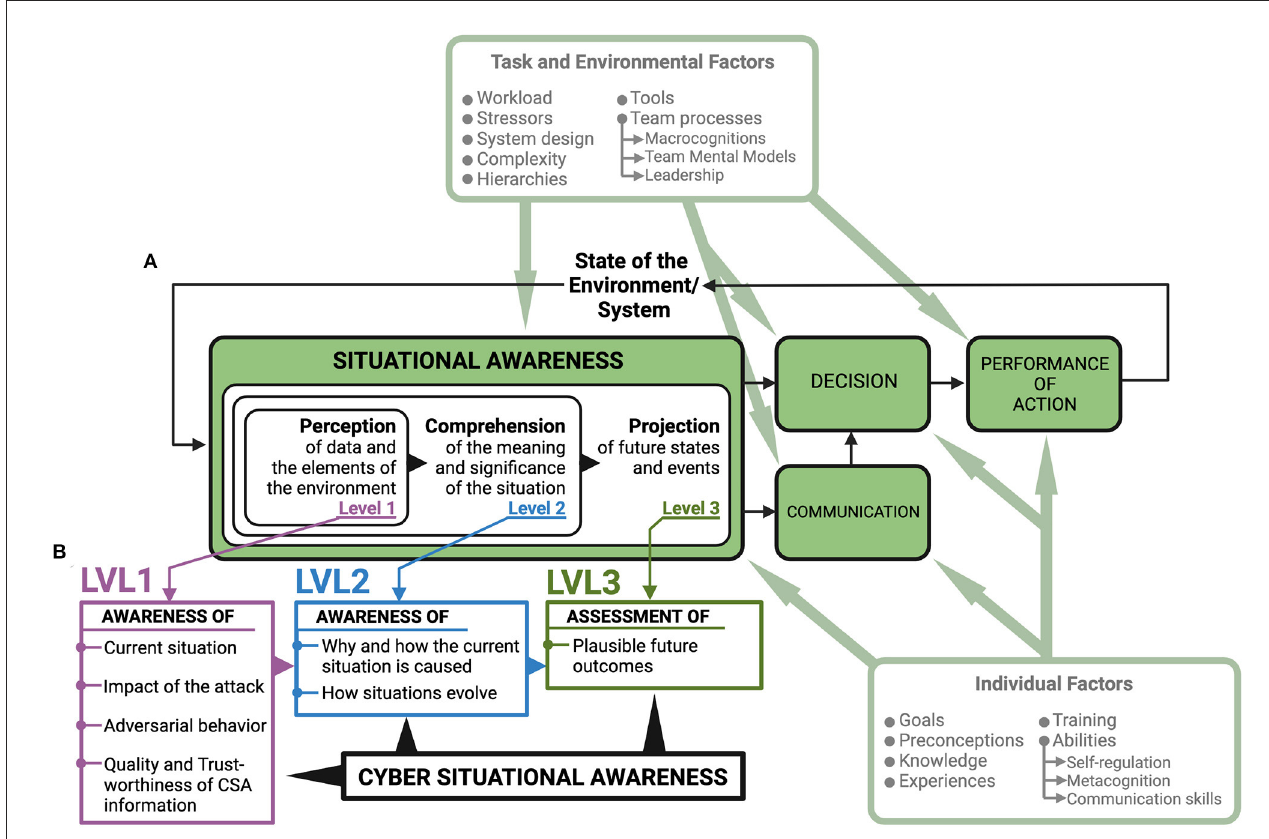
FIGURE1 Situational Awareness model with suggested requirements for achieving Cyber Situational Awareness. (A) Situational Awareness is achieved in three stages (Endsley, 1995). To account for the separation between analysts and decision-makers in SOCs (Knox et al., 2018; Ask et al., 2021a), a “communication” element has been added to the model. (B) Seven requirements that can be organized under the Endsley model need to be met to achieve Cyber Situational Awareness for cyber defense (Barford et al., 2009). Establishing Cyber Situational Awareness, communicating for shared Cyber Situational Awareness, and decision-making based on Cyber Situational Awareness is influenced by individual factors such as emotion, metacognition, self-regulation, and communication skills (Jøsok et al., 2016, 2019; Knox et al., 2017, 2018; Ask et al., 2021b, 2023; Sütterlin et al., 2022) and task and environmental factors such as team-processes including macrocognitions, team mental models, and leadership (Jøsok et al., 2017; Ask et al., 2021a). Modified from Lankton